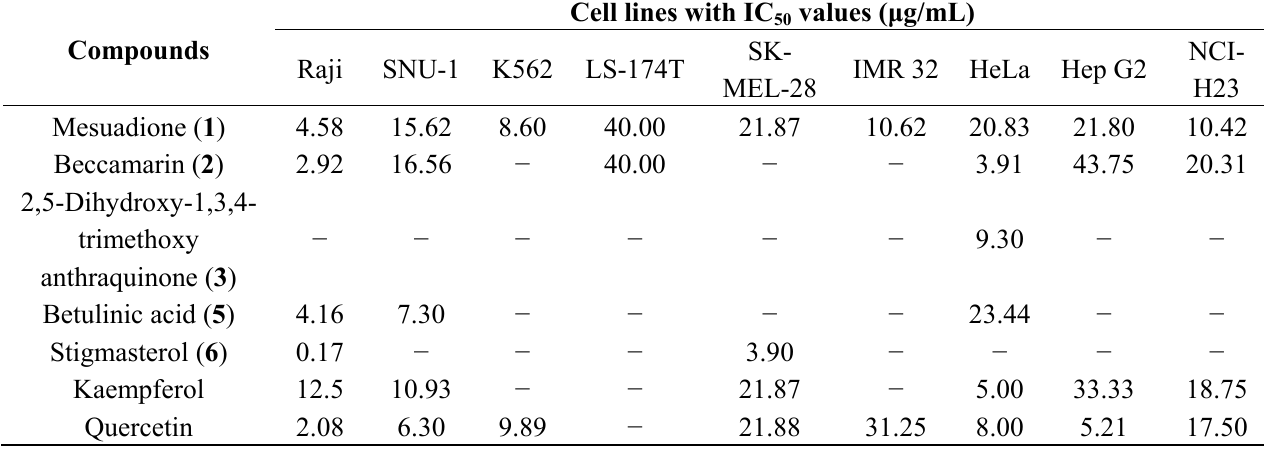
Table 2. IC values of a Panel of Human Cancer Cell Lines Treated with Compounds 1 – 6 50 and standards.